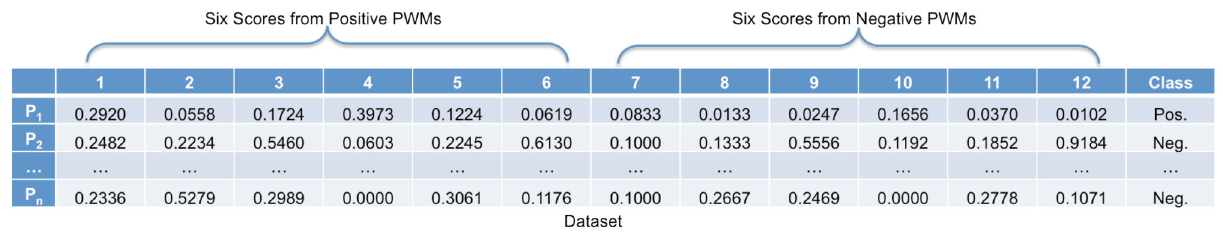
Figure 5. Dataset representation using PWMs. Each pattern in a sentence is represented with twelve features and a class label. The first six features correspond to the scores generated from the positive PWMs, and the following six features correspond to the scores generated from the negative PWMs.